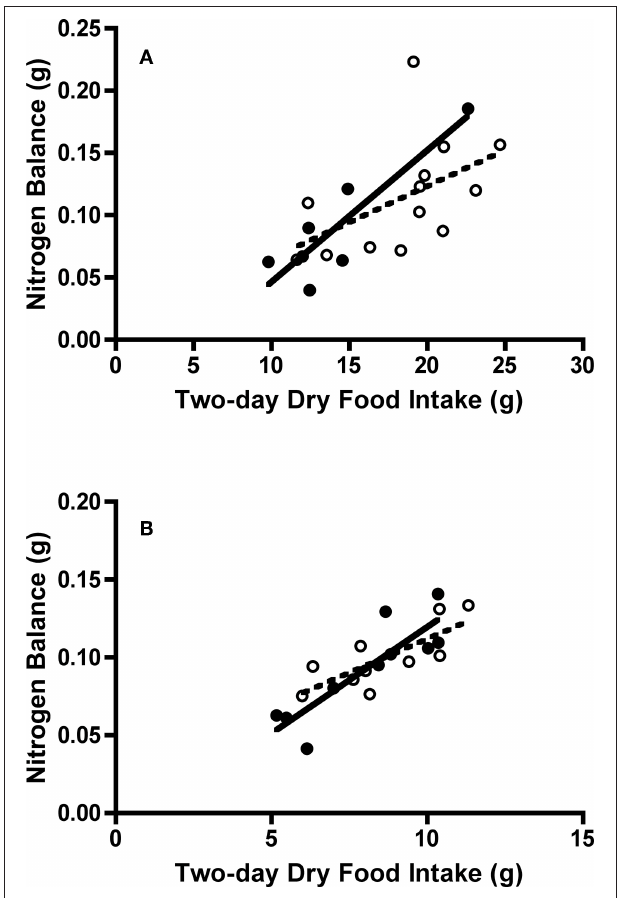
FIGURE 5 | Effect of dry food intake on nitrogen balance of adult and juvenile (A) Swainson’s thrushes and (B) white-throated sparrows during a 2-day total collection mass balance feeding trial. All birds captured at Long Point, ON, Canada during fall 2011 migration stopover. Filled circles and solid lines represent adults: thrushes nitrogen balance = − 0.0588 ( ± 0.0369) + 0.01055 ( ± 0.0025) * dry food intake, r 2 = 0.78; sparrows nitrogen balance = −